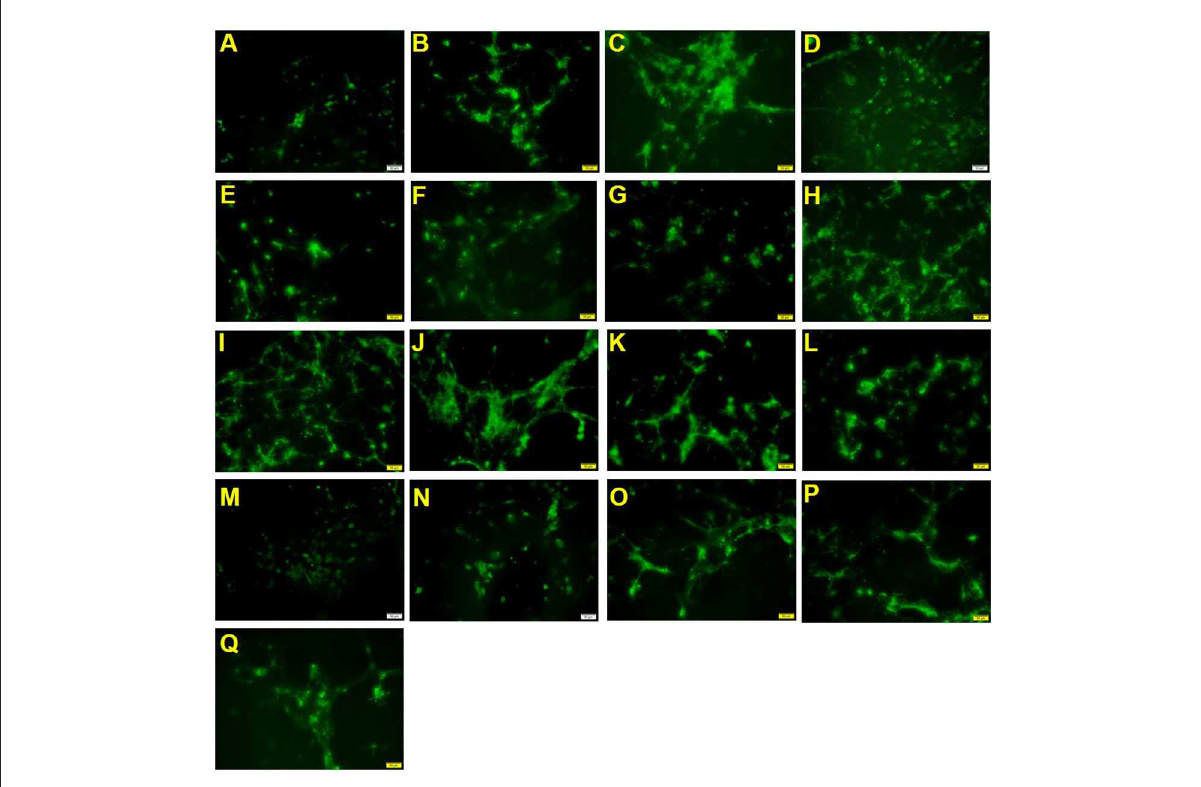
FIGURE3 MBP immunostaining of neural primary cells after treatment with 2 ′ -FL and OPN and DHA for 30 days. (A) , control group; (B) , positive drug; (C) , 2 ′ -FL(H); (D) , OPN(H); (E) , DHA(H); (F) , 2 ′ -FL(L) + OPN(L); (G) , 2 ′ -FL(L) + OPN(H); (H) , 2’-FL(M) + OPN(M); (I) , 2 ′ -FL(H) + OPN(L); (J) , 2 ′ -FL(H) + OPN(H); (K) , 2 ′ -FL(LM) + OPN(LM); (L) , 2 ′ -FL(MH) + OPN(MH); (M) , 2 ′ -FL(L) + OPN(L) + DHA(L); (N) , 2 ′ -FL(L) + OPN(M) + DHA(M); (O) , 2 ′ -FL(H) + OPN(H) + DHA(H); (P) , 2 ′ -FL(LM) + OPN(LM) + DHA(LM); (Q) , 2 ′ -FL(MH) + OPN(MH) + DHA(MH). Scale bar: 50 µ